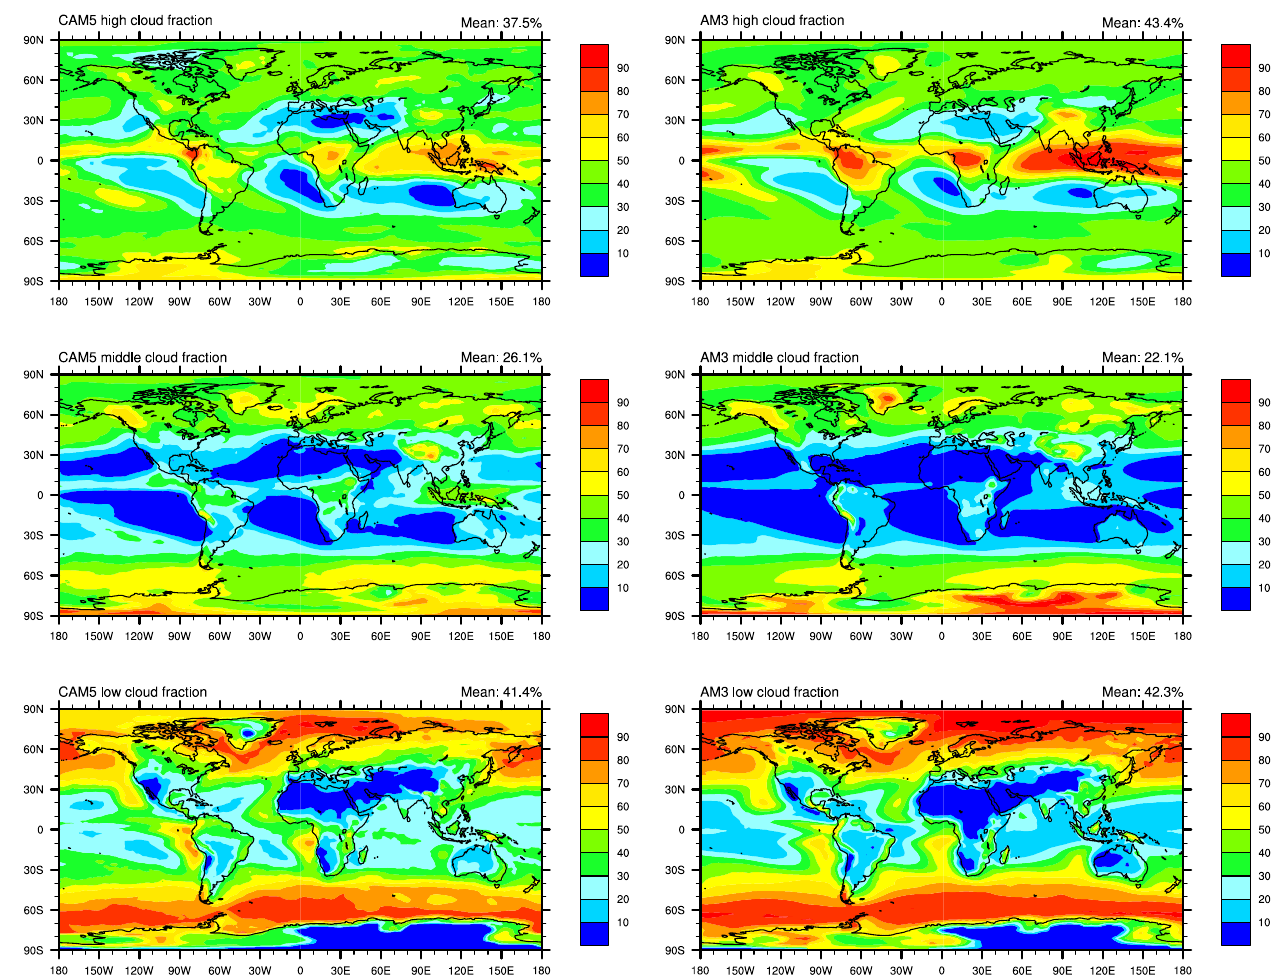
Fig. 12. Annual mean high cloud fraction ( < 440hPa, top panel), middle cloud fraction (440 to 680hPa, middle panel) and low cloud fraction ( > 680hPa, low panel) from CAM5 (left) and AM3 (right).